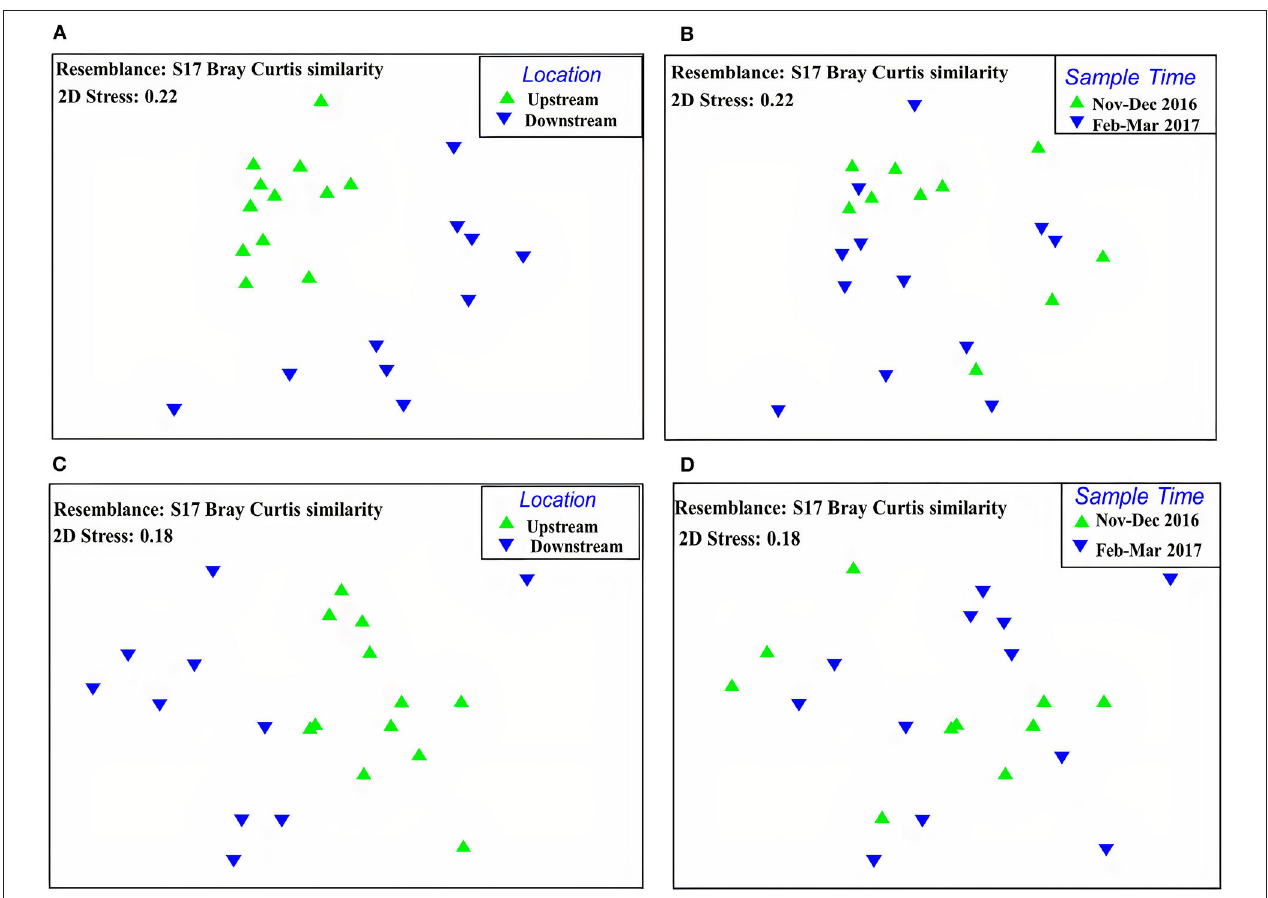
FIGURE 4 | Non-metric Multidimensional Scaling (MDS) plots for comparison of sampling sites (upstream and downstream) and sampling period (November–December 2016 and February–March 2017) in Myitnge River, (A) : the comparison of all taxa communities between sampling sites, (B) : the comparison of all taxa communities between sampling periods, (C) : the comparison of EPTO taxa communities between sampling sites, (D) : the comparison of EPTO taxa communities between sampling periods.